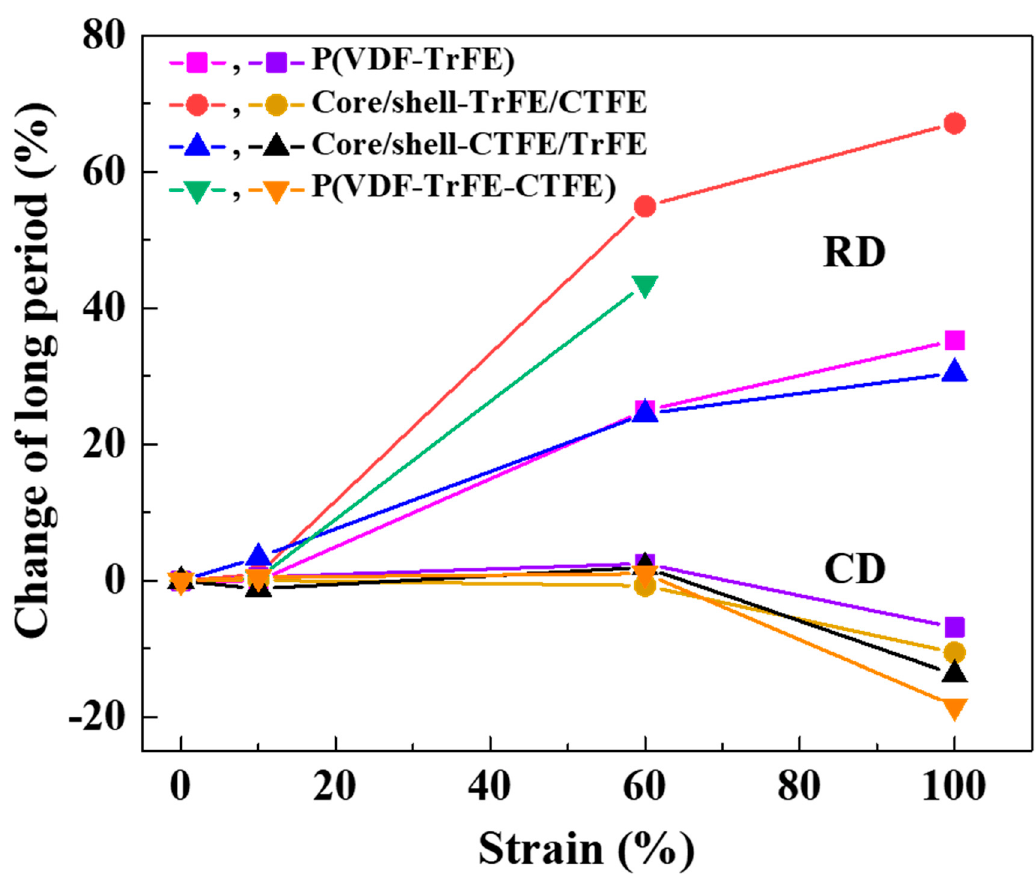
Figure 9. Strain dependence of the percentage changes in the long period of the single and coaxial electrospun membranes in RD and CD.